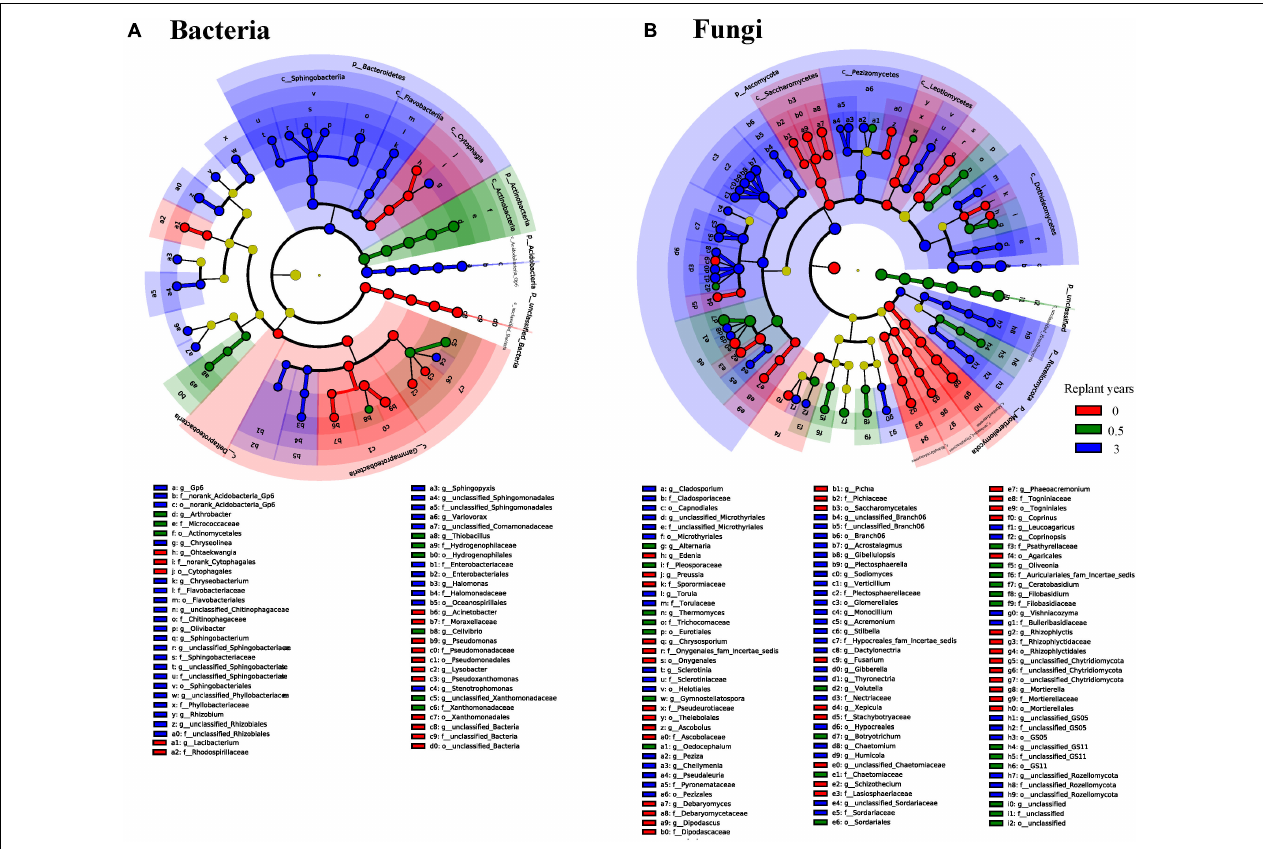
FIGURE 4 | LEfSe of bacterial 16S rDNA (A) and fungal ITS rDNA (B) sequences with different abundances between continuous monoculture periods. The non-significantly different species are uniformly colored yellow, and the different species biomarkers are colored the same as the groups. The names of species represented by letters are shown in the legend on the